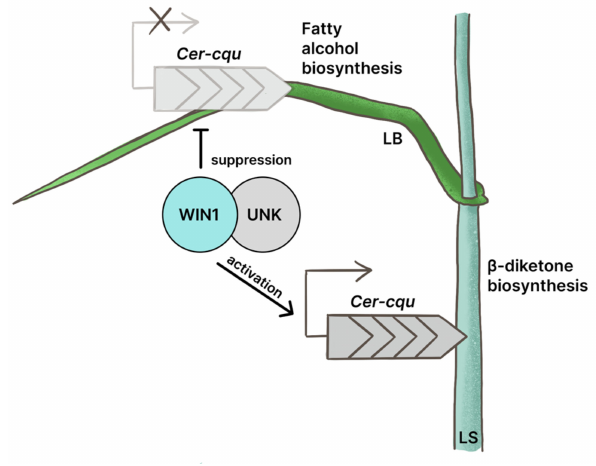
Figure 6. Involvement of WIN1 in the transcriptional regulation of the Cer-cqu gene cluster.